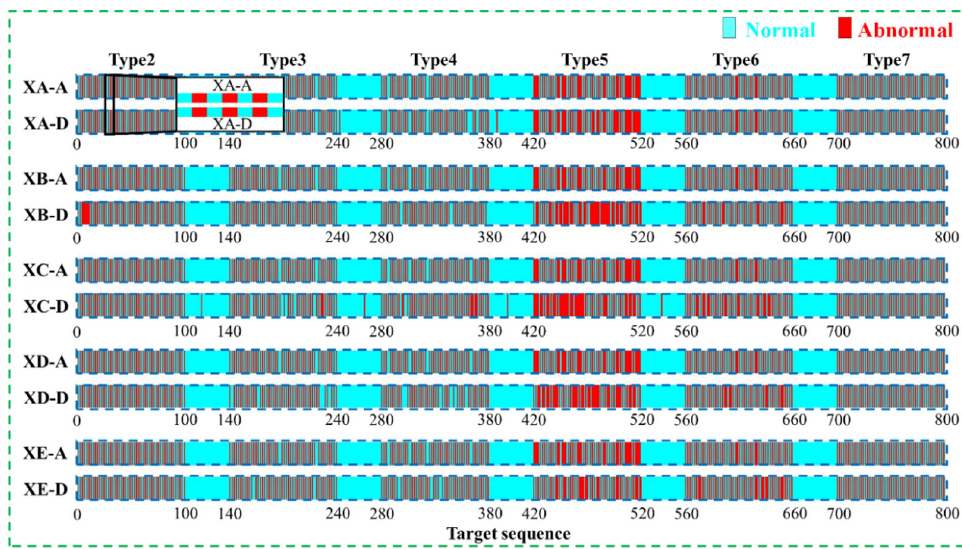
Figure 8. The detection results of numerical example ( ‐ A symbolizes the results with human labeled, ‐ D symbolizes the detected results).